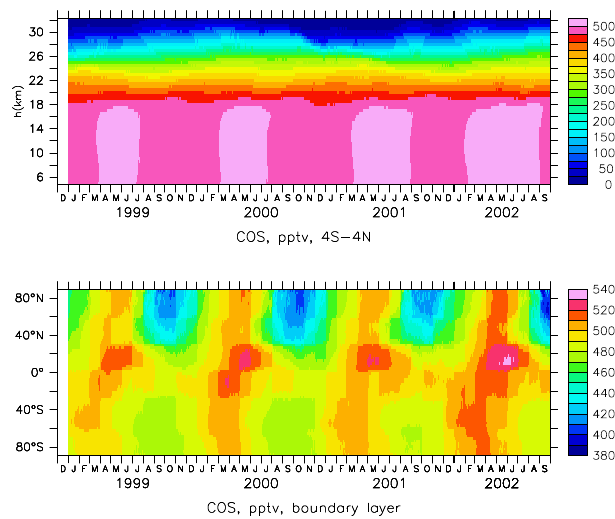
Fig. 1. Time series of COS mixing ratios (inpptv) simulated by EMAC. Upper panel: tropics, colors and altitude range as in Barkley et al. (2008). Lower panel: boundary